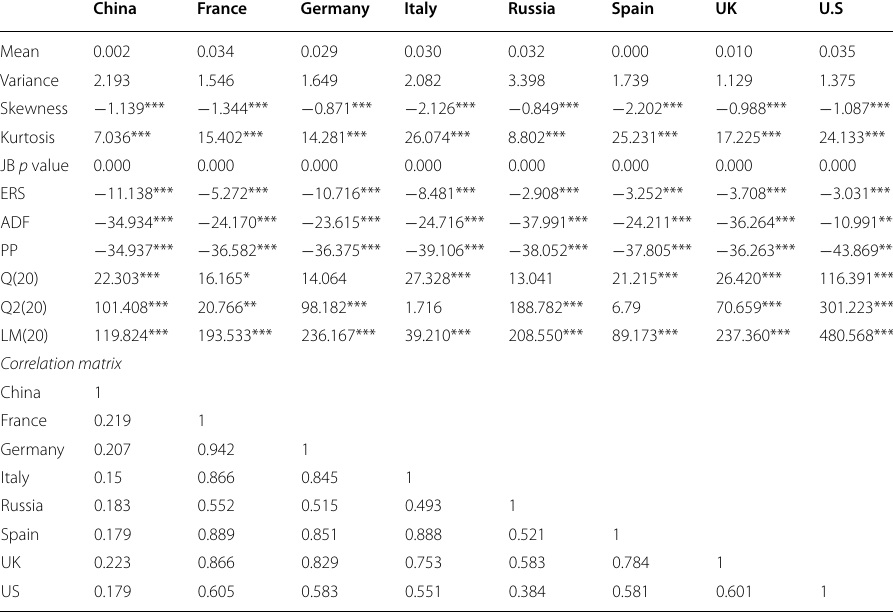
This table reports the descriptive statistics of the considered stock market returns. J.B. is the Jarque–Bera normality test statistics. ERP, ADF, and PP denote the Elliot‑Rothenberg‑Stock, Augmented Dicky‑Fuller, and Phillip‑Perron unit root test, respectively. Q(10) and Q2(10) are the Ljung‑Box tests for 20th order serial correlations for returns and squared returns, respectively. L.M. (20) is the L.M. heteroscedasticity test at order 20. (***), (**), and (*) indicate the statistical significance, respectively, at 1%, 5%, and 10%